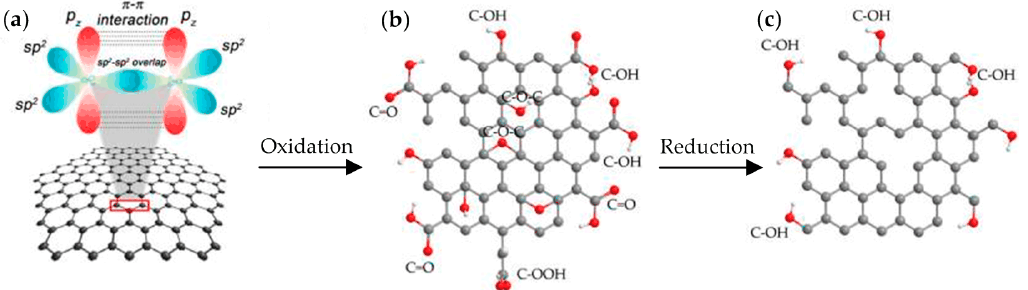
Figure 2. ( a ) Pristine graphene (pure-arranged carbon atoms) with sp 2 -hybridized carbon atoms and ( b ) graphene oxide (GO) and ( c ) reduced graphene oxide (rGO) of the chemically modified graphene [35].